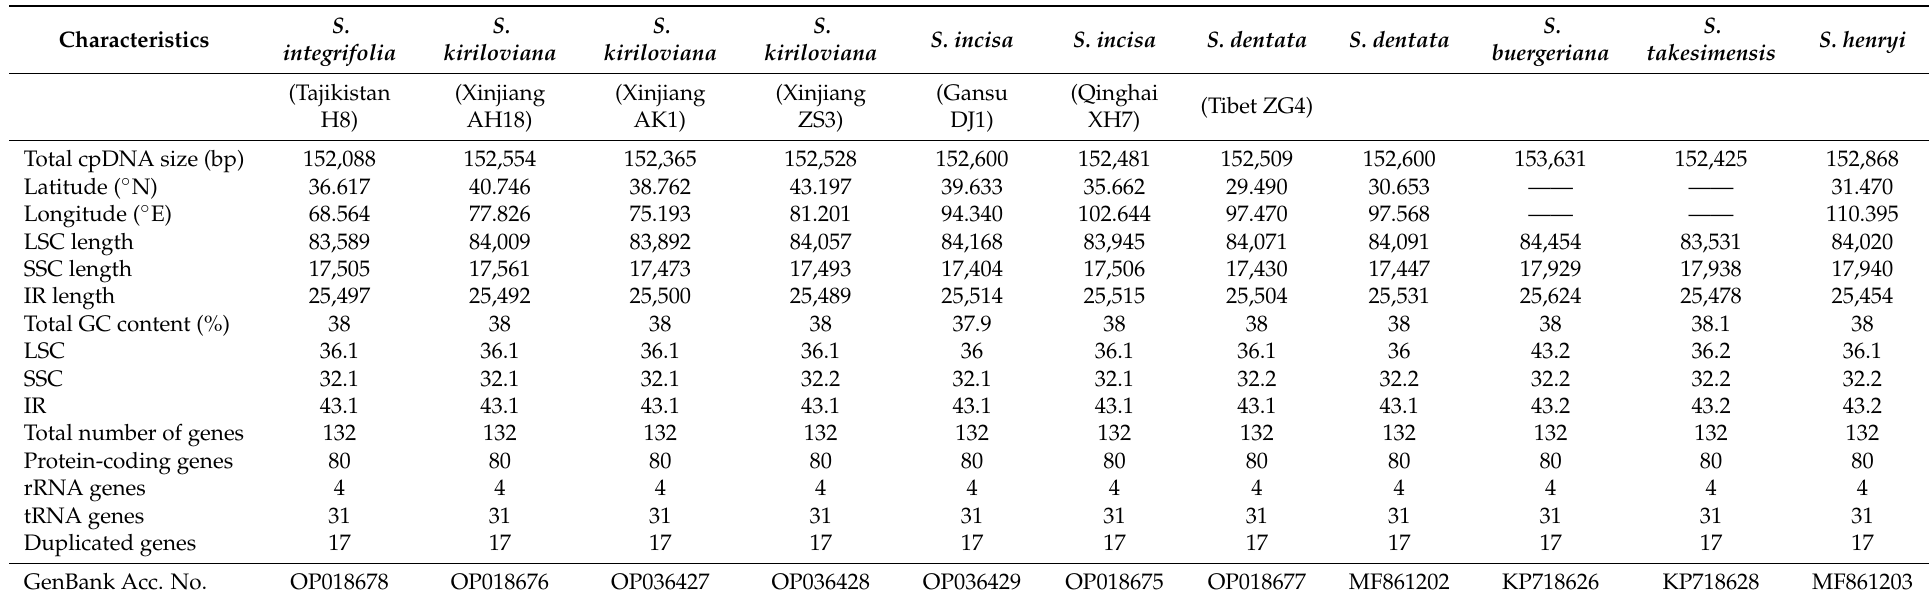
Table 1. The basic characteristics of Scrophularia chloroplast